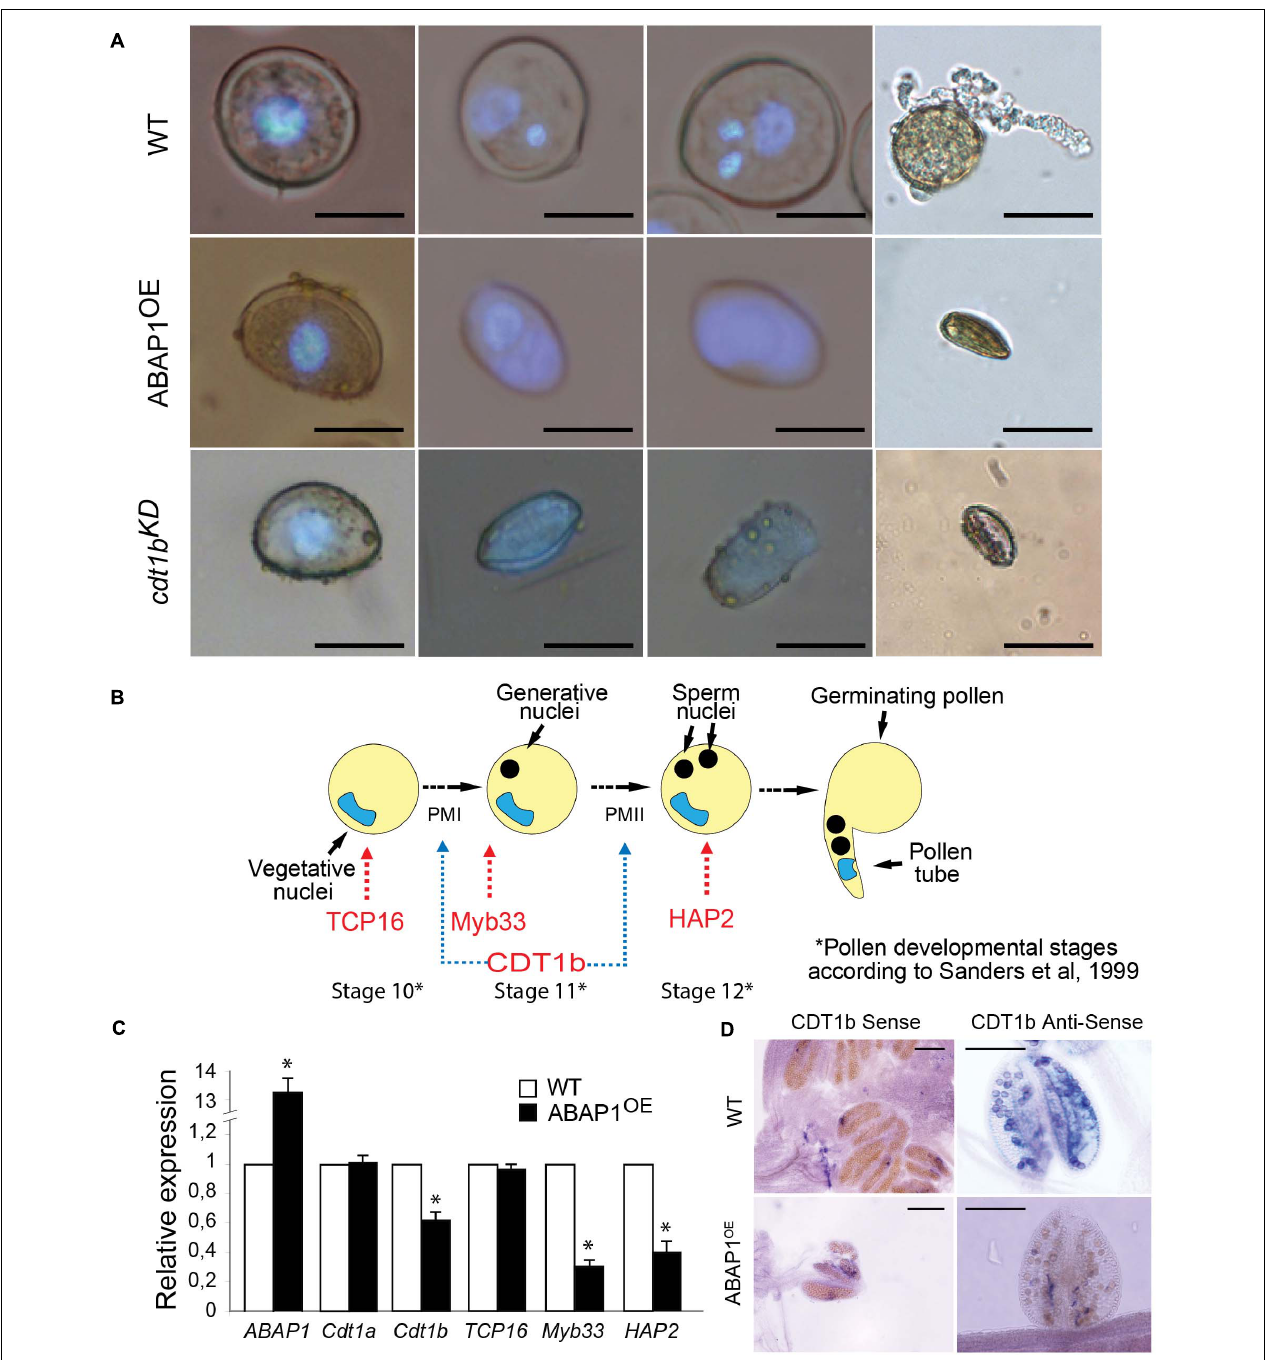
FIGURE 3 | Defective pollen maturation in ABAP1 OE plants. (A) Pollen grains stained with DAPI in different developmental stages, in WT plants (upper line), ABAP1 OE plants (middle line) and cdt1b KD (bottom line). (B) Schematic representation of the series of events taking place after meiosis, during the maturation of the male gametophyte in Arabidopsis. PMI and PMII are the two mitotic divisions necessary for the male gametophyte development. Red arrows indicate marker genes of pollen developmental stages. Blue arrows indicate the stages when CDT1b might be required for mitotic cell division. (C) Relative mRNA levels of ABAP1, CDT1a, CDT1b, TCP16, Myb33, and HAP2 were determined by qRT-PCR in wild-type and ABAP1 OE anthers at stage 12 of development (according to Sanders et al., 1999). Data were normalized with UBI14 as reference gene and were compared with wild-type. Each biological replicate was performed with a pool of 50 anthers. Bars indicate mean ± standard error of biological replicates. A statistical analysis was performed by t -test ( p -value < 0.05). Asterisks ( ∗ ) indicate significant changes. (D) CDT1b mRNA levels in wild-type and ABAP1 OE anthers using whole mount in situ hybridization with anti-sense probes. Hybridization signals are seen as purple dots under bright field optics. The scale bars represent 20 µ m in (A) and 0.2 mm in (D) .